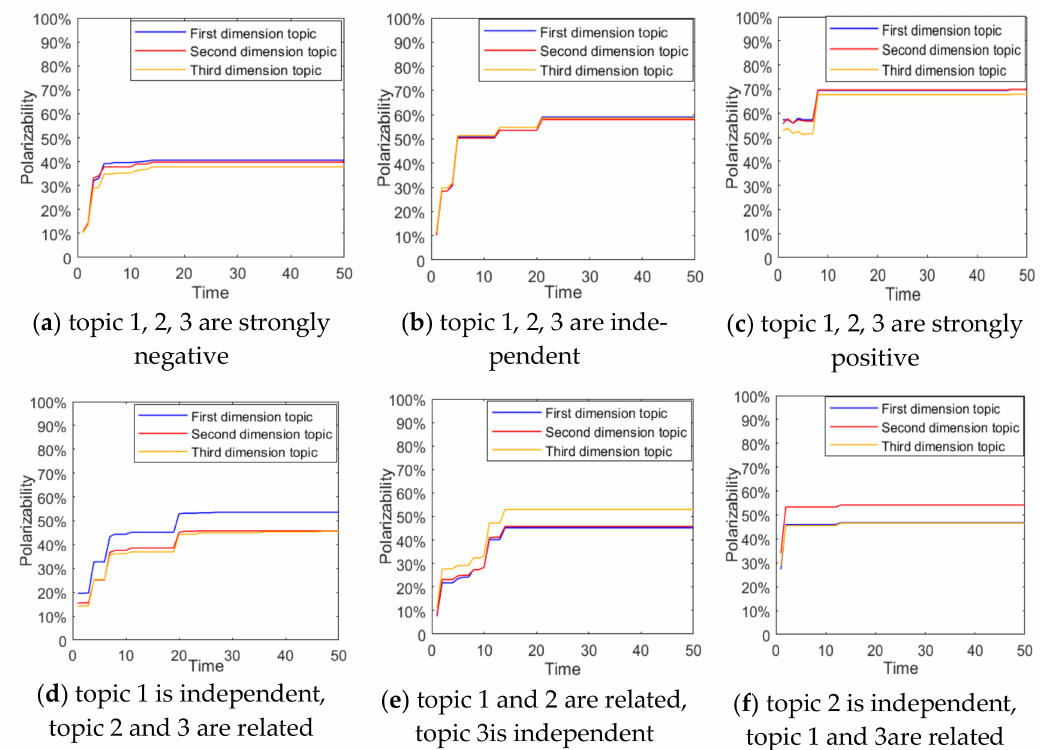
Figure 13. The polarizability curves of group attitudes under different topic